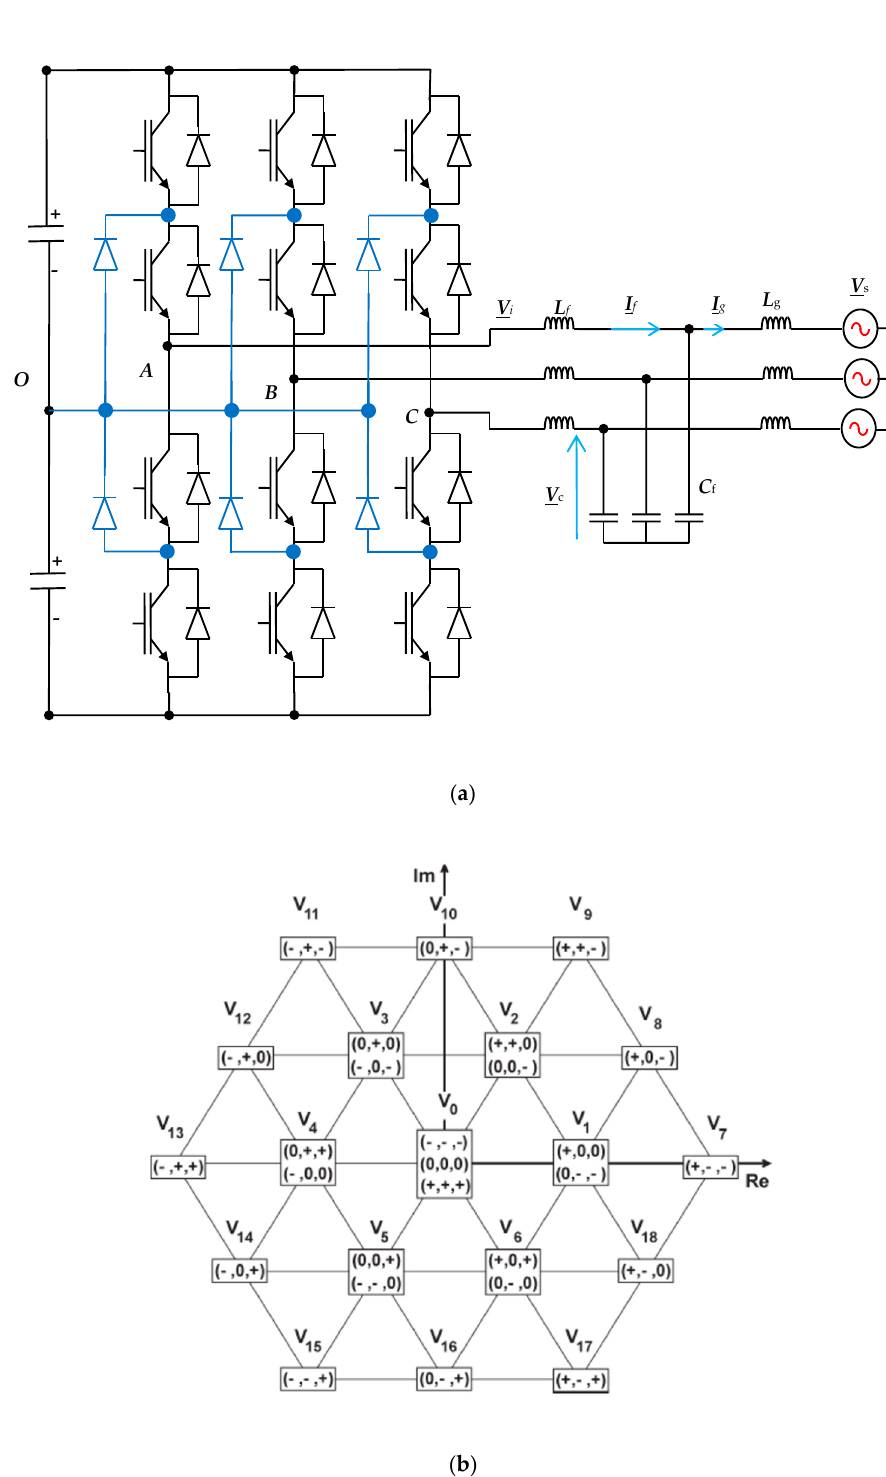
Figure 4. ( a ) The power circuit diagram of an NPC 3- φ inverter and ( b ) the inverter space vectors.